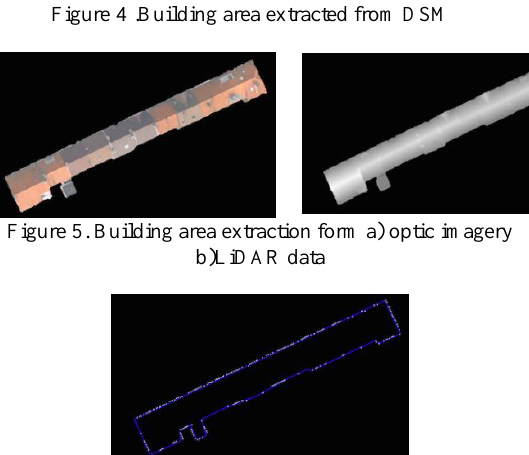
Figure 4 .Building area extracted from DSM